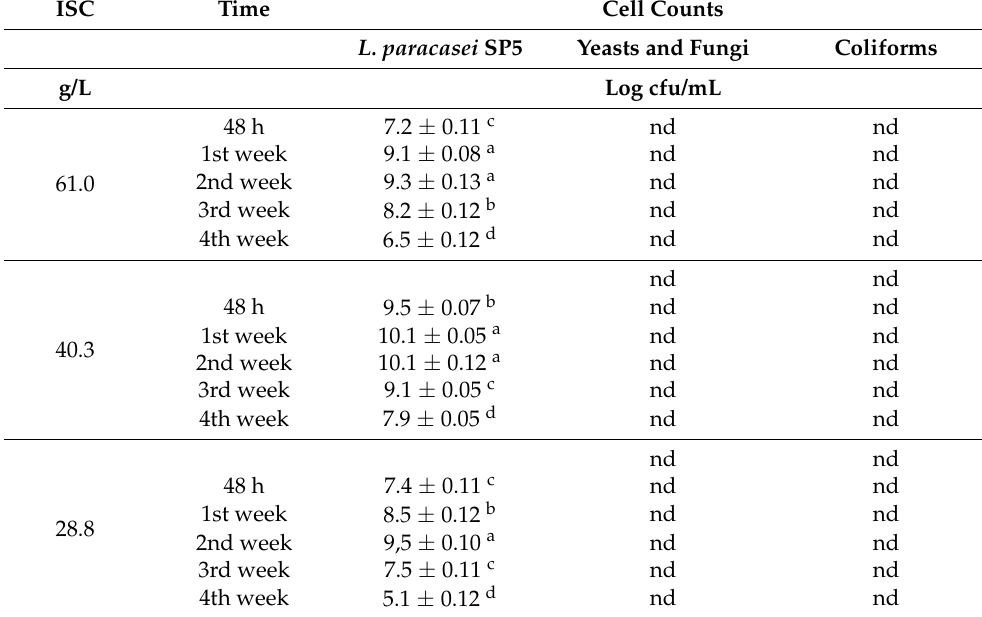
Table 1. Viability of the potential probiotic strain Lactobacillus paracasei SP5 in the fermented choke- berry juice at 30 ◦ C in different initial sugar concentrations (ISC) after 48 h and 4 weeks. ISC Time Cell Counts L. paracasei SP5 Yeasts and Fungi Coliforms g/L Log cfu/mL